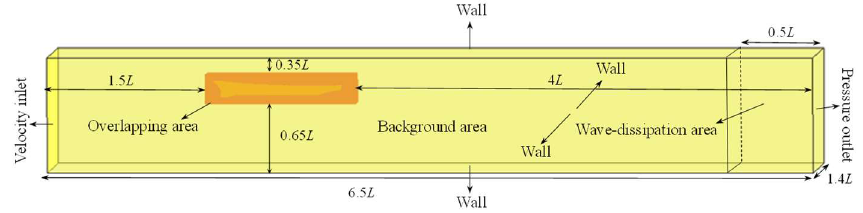
Figure 3. Sketch of the computational domain.